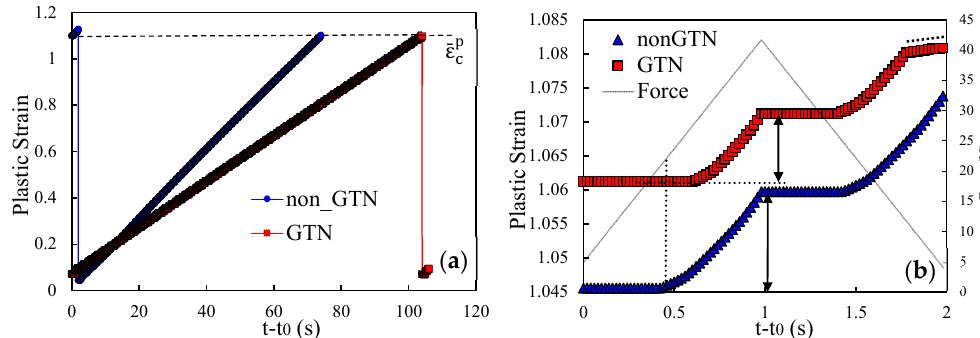
Figure 4. Comparison of the plastic strain evolution with and without GTN for a 0 = 11.5 mm. ( a ) Time period between the 25th and the 26th node releases. ( b ) A single load cycle, immediately before the 26th propagation.